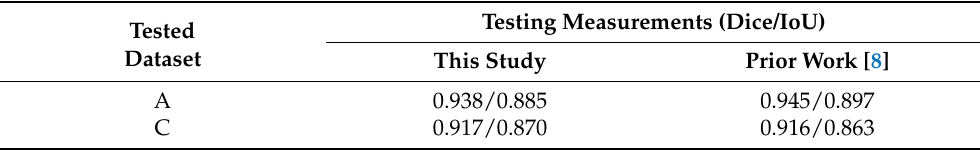
Figure 4. The segmentation predictions on test images of dataset D. Green lines mark the predicted boundaries. The 5 images in the top row are sample results randomly selected across the test dataset. Images in the bottom row are segmentation predictions from a single same-time sequence (one patient). The frame indexes are 1st, 4th, 8th, 13th, and 17th in the time sequence, from left to right, correspondingly. Table 2. Results of testing our segmentation results on datasets A and C. Note that the previous method [8] referenced here is a Mask x R-CNN model with a base net of ResNet50 architecture in the feature pyramid and the region proposal network. The measurements use Dice/IoU scores.